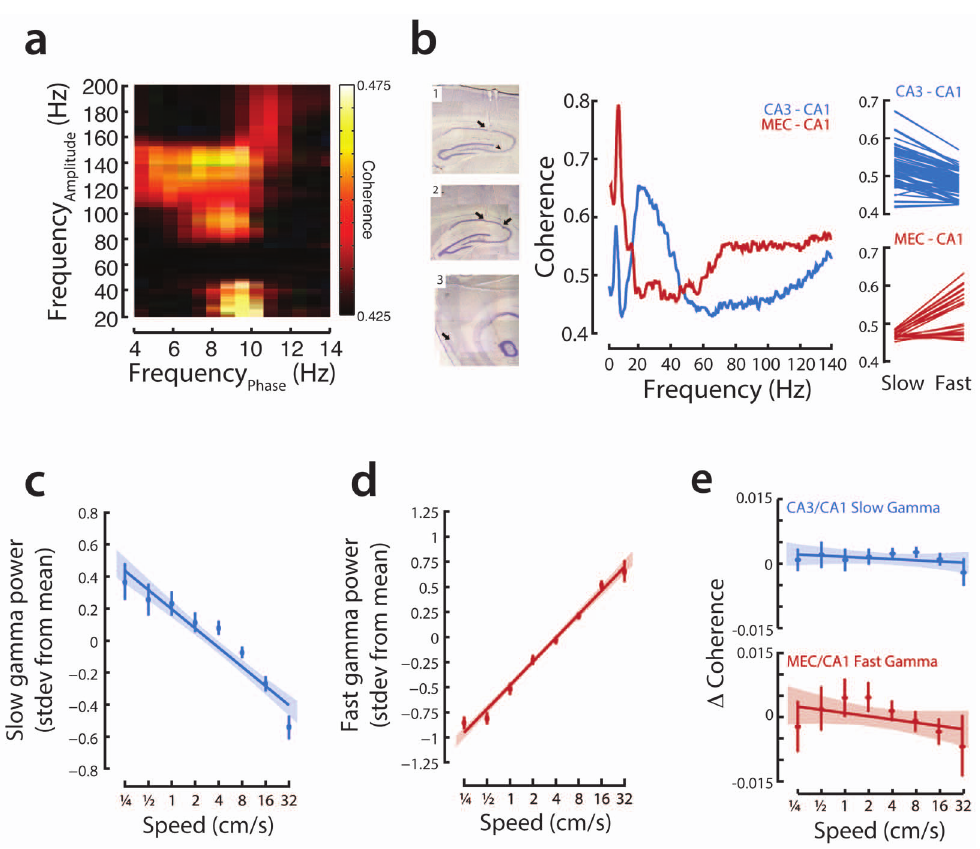
Figure 3. Slow and fast gamma oscillations in CA1 are modulated by speed. a, There are two distinct gamma bands in CA1. Shown is an example cross-frequency coherence plot from a novel run session showing that gamma power (y-axis) is modulated by the theta phase (x-axis). b, CA1 is more coherent with CA3 in slow gamma range and more coherent with layer 3 of the medial entorhinal cortex in fast gamma range. Coronal and sagittal sections show electrolytic lesions in recording sites from CA3-CA1 recordings (1) and CA1-MEC recordings (2 and 3). Coherence plots for a representative pair of CA3-CA1 (blue) and MEC-CA1 (red) recordings. There is a pronounced peak in the slow gamma range (25–55 Hz) of CA3-CA1 coherence, and a noticeable increase in the fast gamma range ( , 70–130 Hz) of MEC-CA1 coherence. Slow gamma coherence was greater than fast gamma coherence for 80 out of 85 pairs of CA3-CA1 recordings (z-test for proportions, p , 10 2 5 ; n=5 animals), while fast gamma coherence was greater than slow gamma coherence for 19 out of 22 pairs of MEC-CA1 recordings (z-test for proportions, p , 10 2 5 ; n=3 animals). c, Population data showing normalized power of slow gamma vs. speed. Points represent binned means with standard error using logarithmically spaced bin centers; line represents linear regression of underlying data with 95% confidence intervals. d, Population data showing normalized power of fast gamma oscillations vs. speed. Points and line as in ( c ). e, There are very small changes in coherence as a function of behavioral state. (top) Average change in coherence between CA3 and CA1 in the slow gamma frequency band (n=4 animals) as a function of speed (average slow gamma coherence between CA3 and CA1=0.51). Coherence was measured for all tetrode pairs. For each pair, the deviation from the mean value in each 500 ms time window was calculated. Each time window was associated with the appropriate speed. Shown are the regression of speed and change in coherence with 95% C.I. and binned histograms as in ( c ). Change in coherence vs. speed is not significantly different from zero (bootstrap test). (bottom) Average change in coherence between MEC and CA1 in the fast gamma frequency band (n=3 animals, average mean fast gamma coherence between MEC and CA1=0.49). Change in coherence vs. speed is not significantly different from zero (bootstrap test).